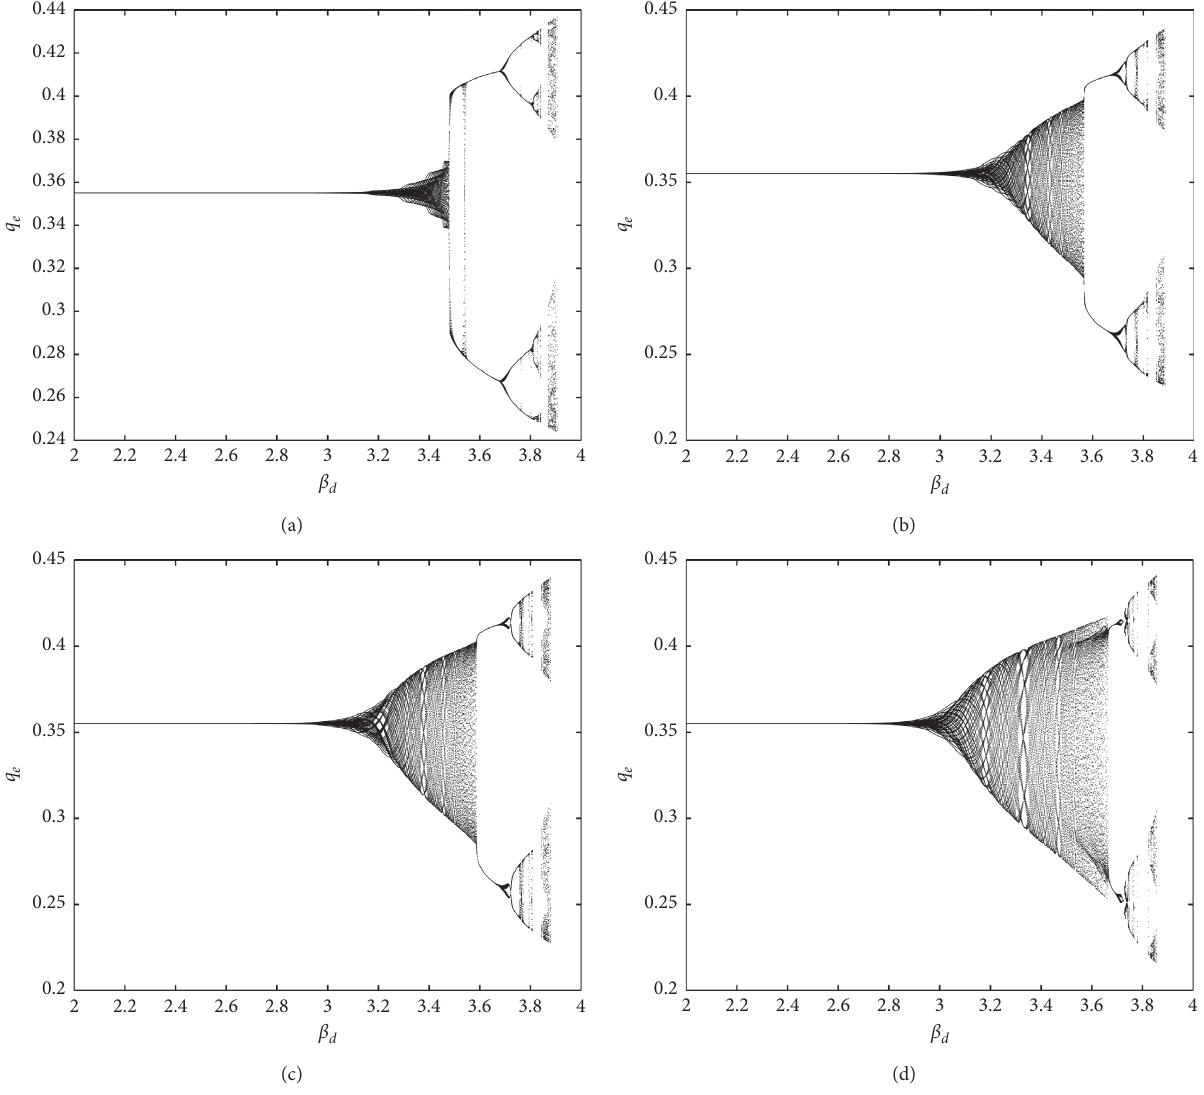
Figure 6: Bifurcation diagrams of q